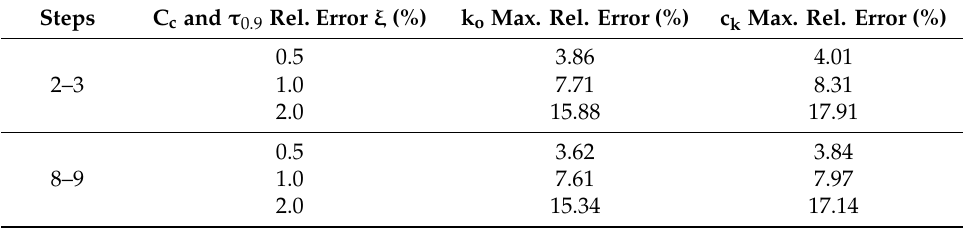
Table 15. Maximum errors of k o and c k as a function of ξ